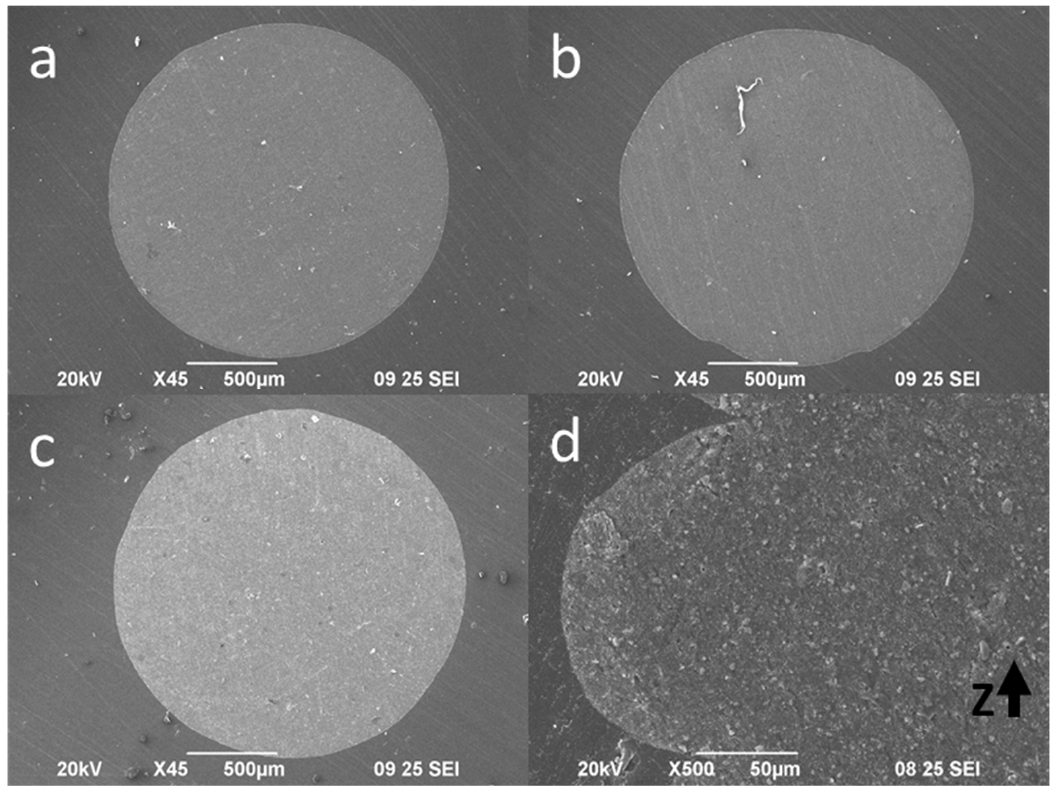
Figure 6. SEM micrographs of the ground cross-sections of the V1 filament ( a ), V2 filament ( b ), V3 filament ( c ) at mag. ×45, and V3 printed cubic sample ( d ) at mag. ×500, Z: vertical printing direction.